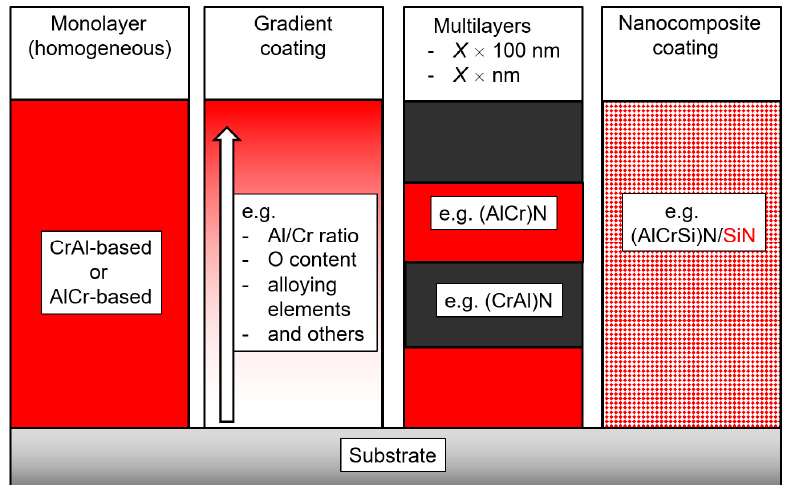
22 Figure 22. Main types of coating